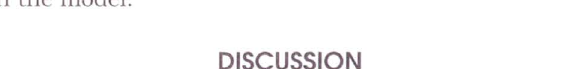
factors measured. intravenous drug use had an RR of 4.4 (range 2.9 to 6.7) for HBV and 3.4 (range 2.7 to 4.3) for IICV. Tattooing had an RR of 1.5 (range 1.3 to 1.8) for IIBV and IICV. A history of transfusion was not a risk factor for either HBV or IICV (RR l.l and 1.0, respectively). Sexual preferences could not be analyzed as a risk Multivariate analysis using multiple regression showed that intravenous drug use, tattoos and age were all significantly associated witl1 HBV, in that order. while for HCV only intravnous drug use was